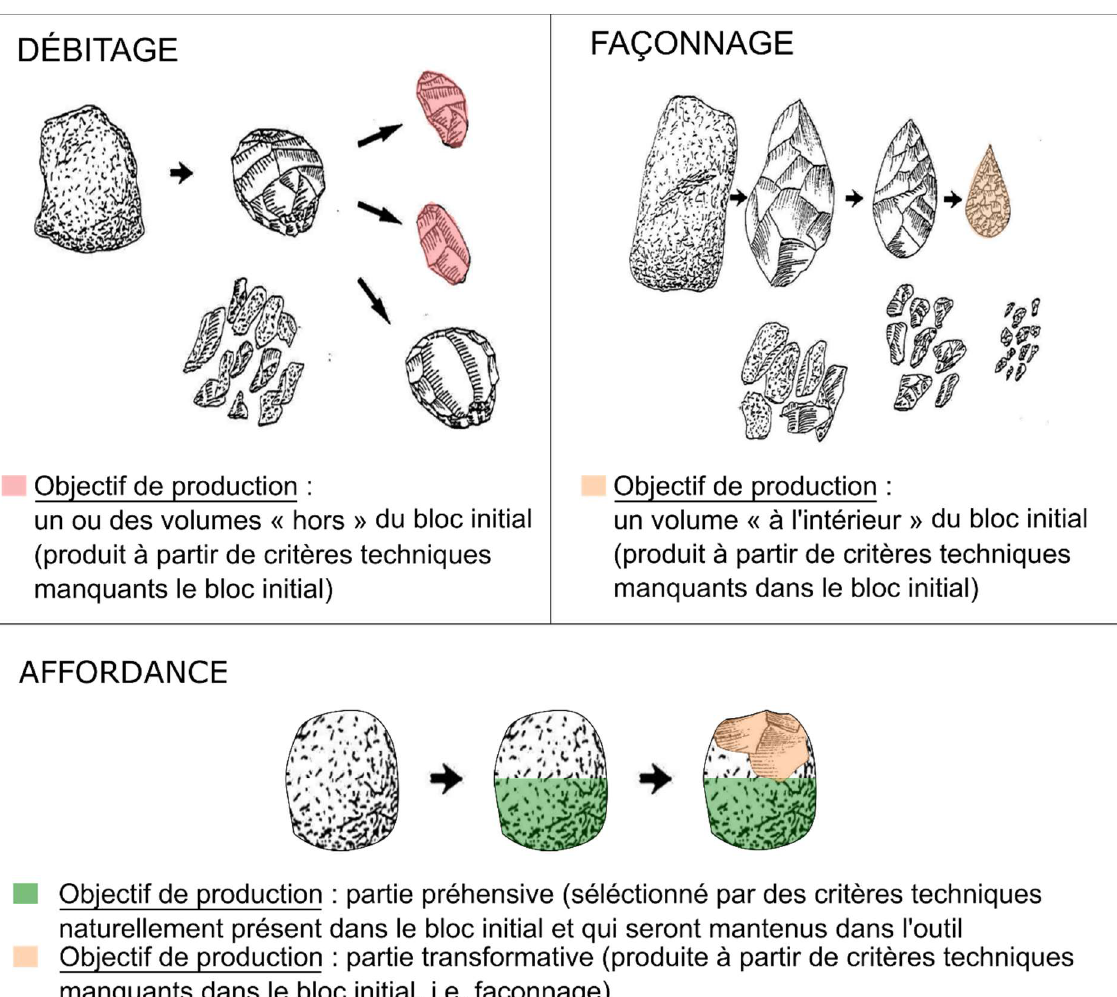
Figure 10. Trois opérations techniques impliquées dans la production d'outils en pierre taillée (élaborée à partir de Boëda 1997, figure